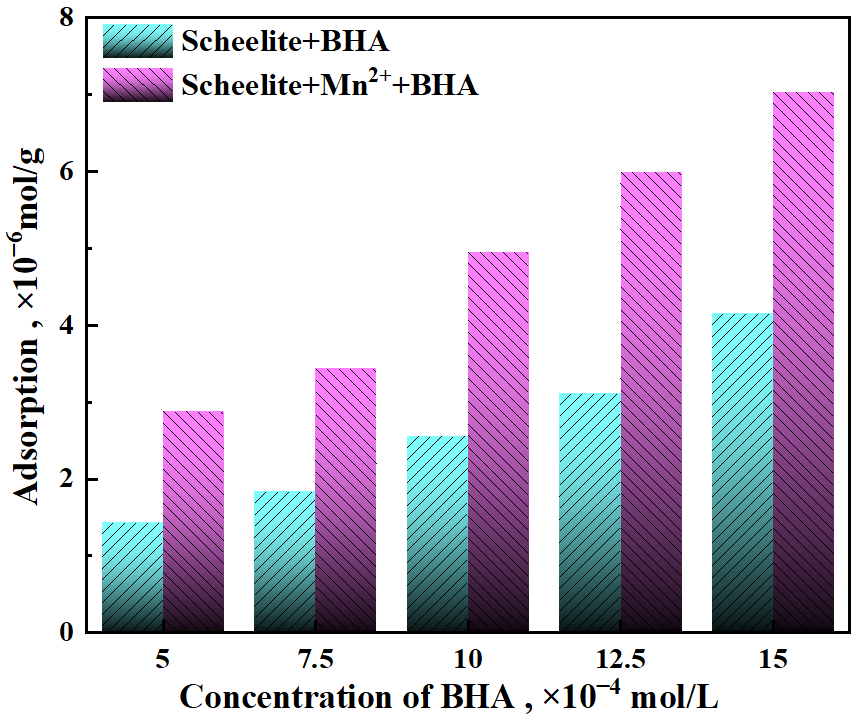
Figure 5. Effect of Mn 2+ (2 × 10 −4 mol/L) on the adsorption of BHA on minerals surfaces.